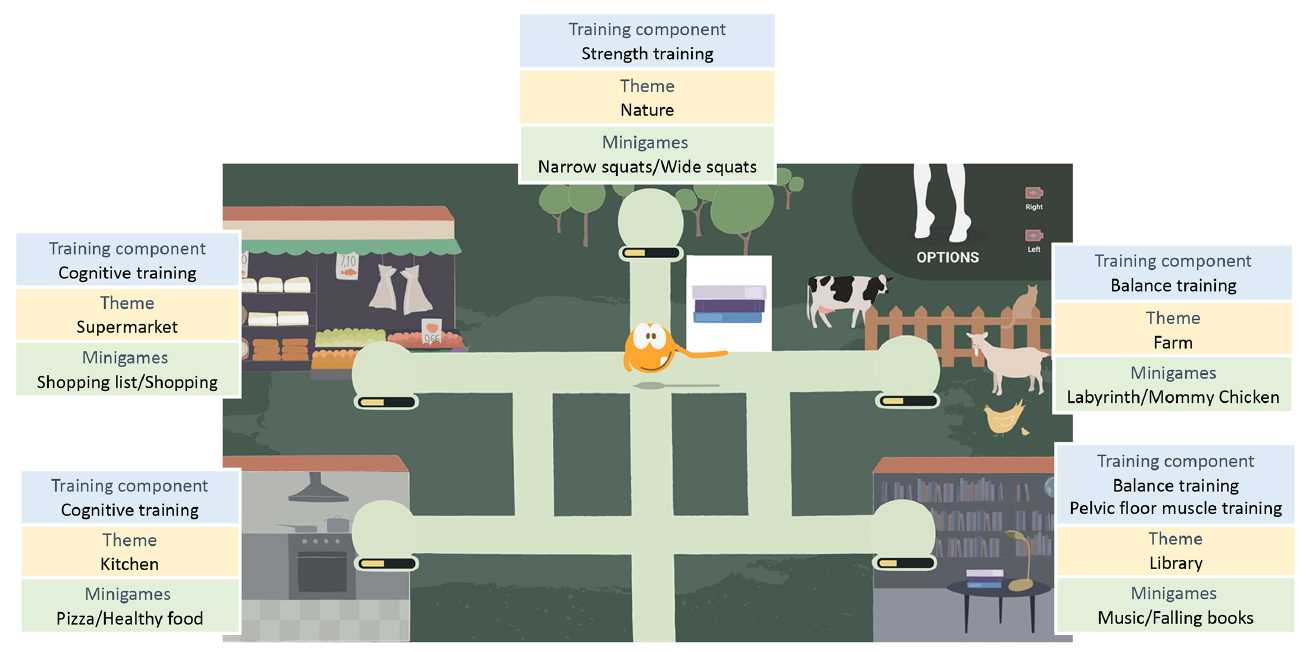
Figure 1. Main board: Training components, themes and